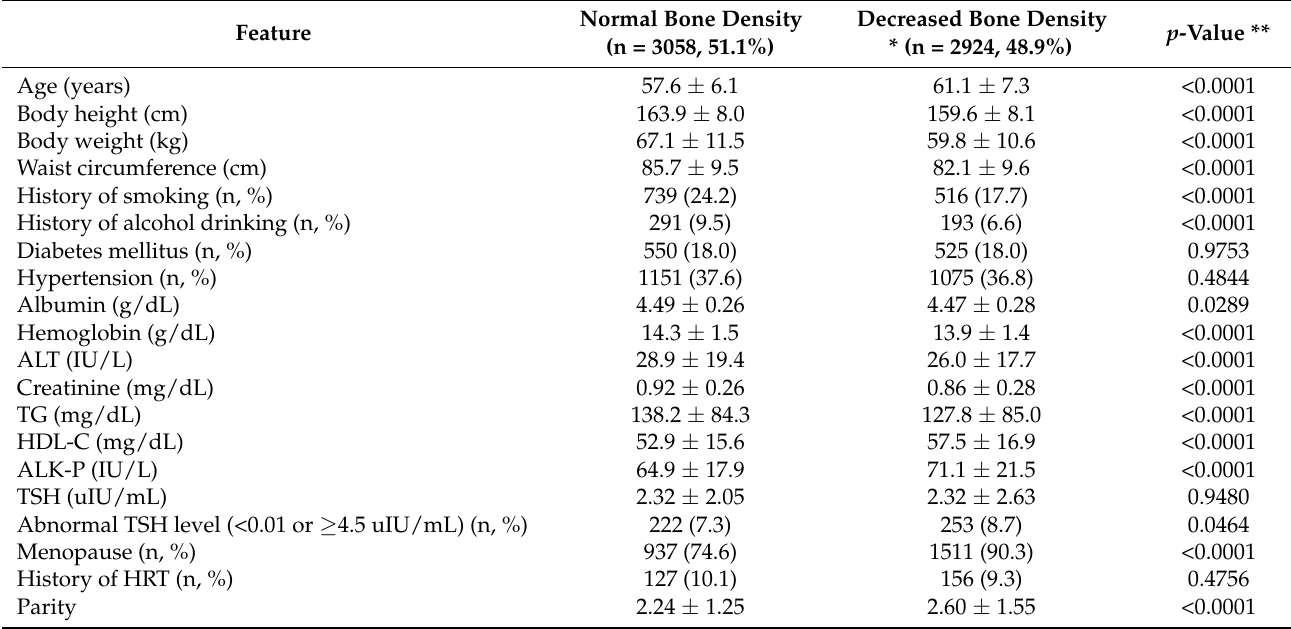
Table 3. Comparison of the input features between participants with normal bone density and decreased bone